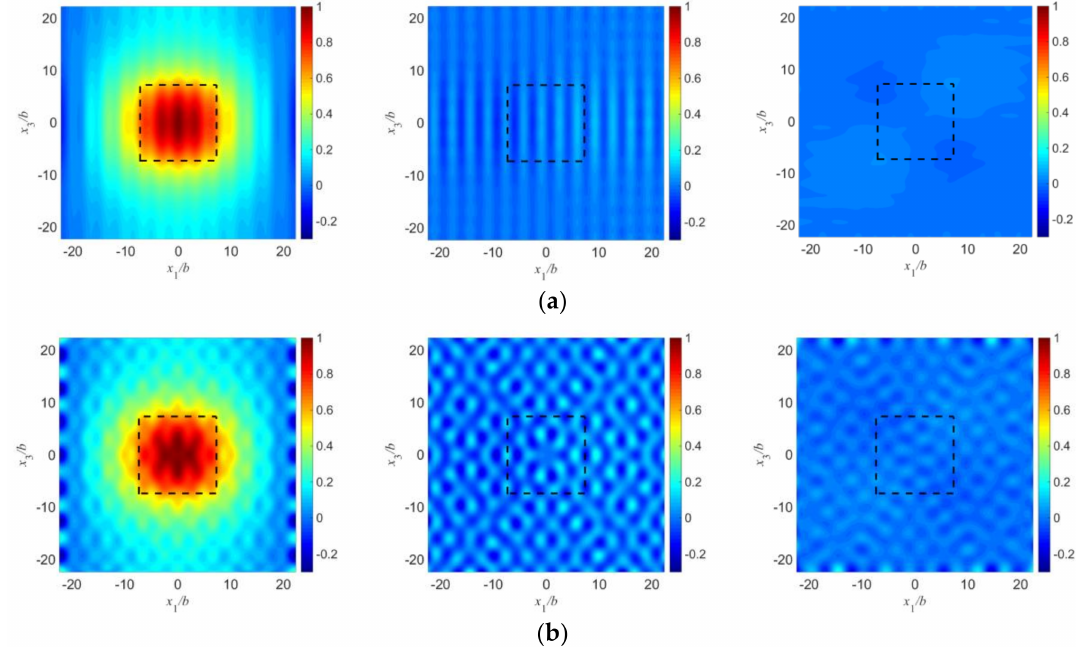
Figure 3. Essential thickness-shear (TS) modes with strong or weak mode coupling. ( a ) Point A: a / b = 7.26, d / b = 15, R = 0.01, Ω = 0.99824127; ( b ) Point B: a / b = 7.34, d / b = 15, R = 0.01, Ω =